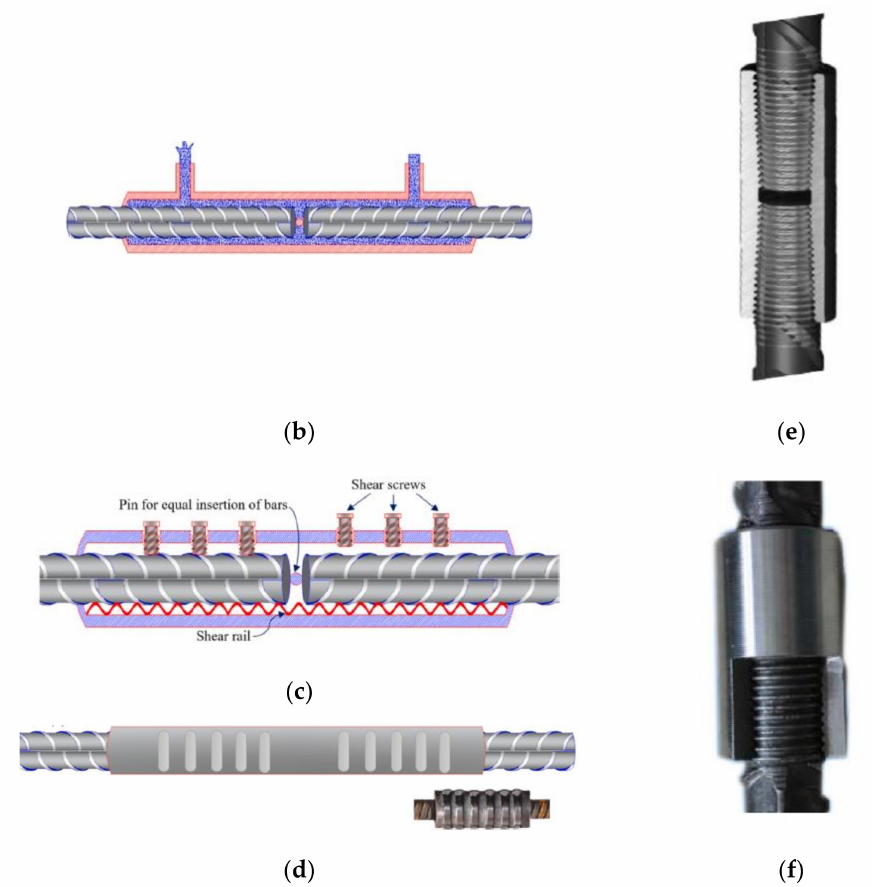
Figure 2. Splice types considered in the database: ( a ) headed bars, ( b ) grouted splice, ( c ) shear-screw,